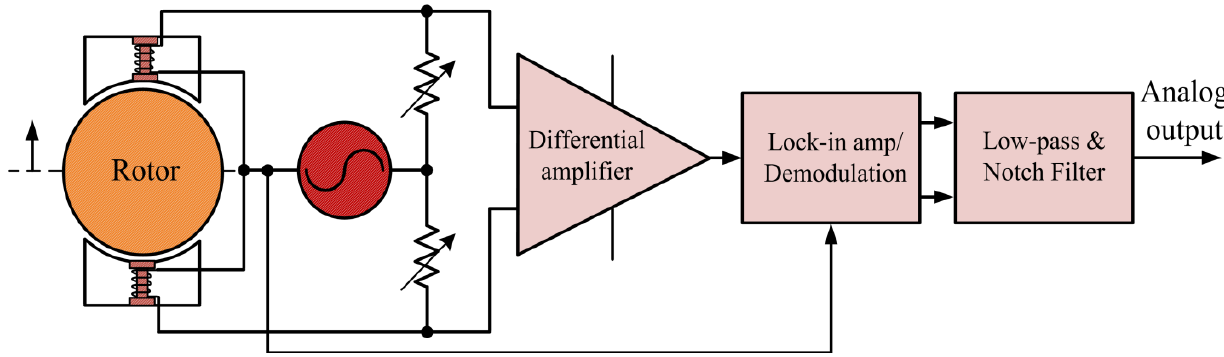
Figure 15. The inductive displacement sensor block